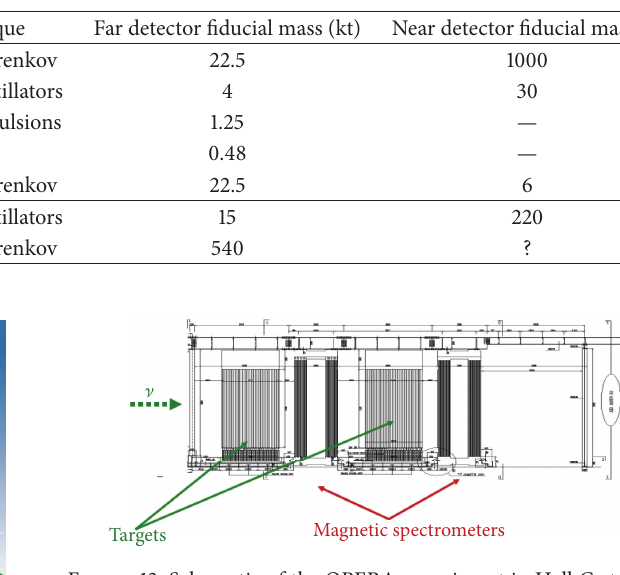
Figure 13: Schematic of the OPERA experiment in Hall C at Gran